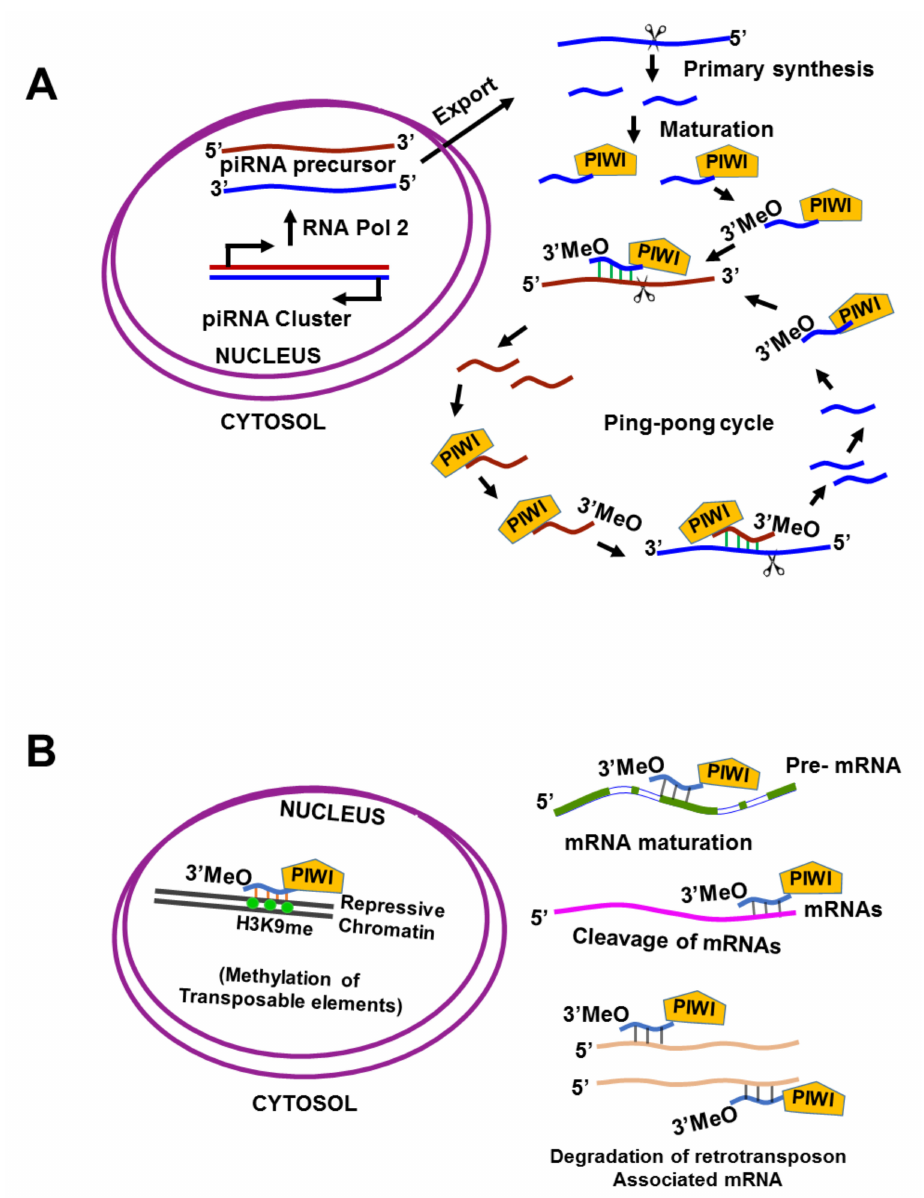
Figure 1. Biogenesis and function of piRNAs. ( A ) Biogenesis of piRNAs: Biogenesis of piRNA occurs through primary and secondary pathways (ping-pong cycle). In the primary pathway, piRNA precursors are transcribed from piRNA clusters by RNA polymerase 2 (RNA Pol2). Antisense primary piRNAs are cleaved, trimmed into short fragments, and their 3 (cid:48) ends are 2 (cid:48) - O -methylated and then loaded onto PIWI family proteins. In the secondary amplification pathways, also known as the ping-pong cycle, PIWI proteins associate with antisense piRNA and cleave piRNA precursors in the sense strand, or PIWI proteins associate with sense piRNA and cleave antisense piRNA precursors in the sense strand. The incorporated RNA is therefore processed into a mature secondary piRNA by trimming and modification, likely by the same mechanisms that generate a primary